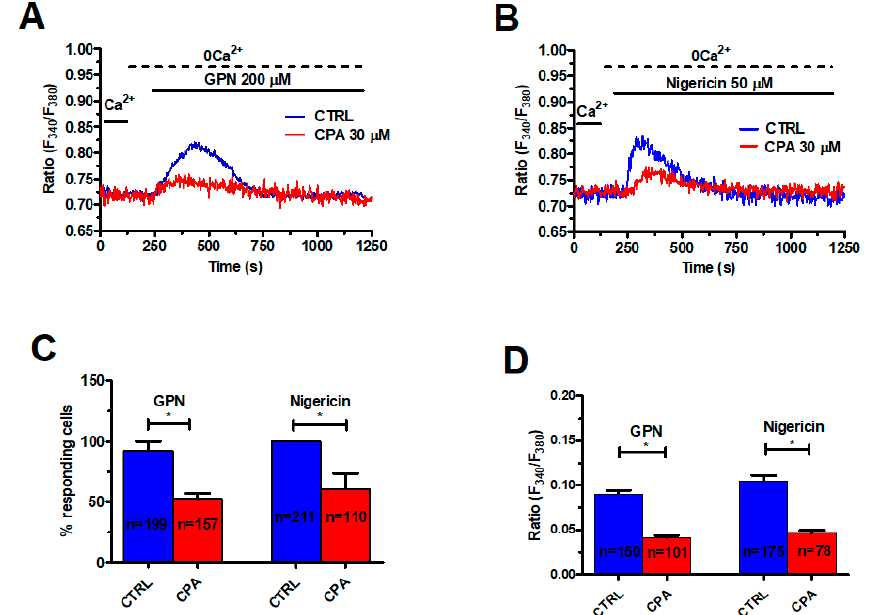
Figure 2. The endoplasmic reticulum (ER) Ca 2+ store supports the Ca 2+ response to GPN and nigericin. ( A ) depletion of the ER Ca 2+ store with cyclopiazonic acid (CPA) (30 µM, 30 min) impaired GPN- induced Ca 2+ signals in mCRC cells. GPN was administered at 200 µM. ( B ) CPA (30 µM, 30 min) also impaired the transient Ca 2+ response to nigericin (50 µM). ( C ) mean ± SE of the percentage of responding cells under the designated treatments. The asterisk indicates p < 0.05. ( D ) mean ± SE of the amplitude of the Ca 2+ response to GPN and nigericin under the designated treatments. The asterisk indicates p <